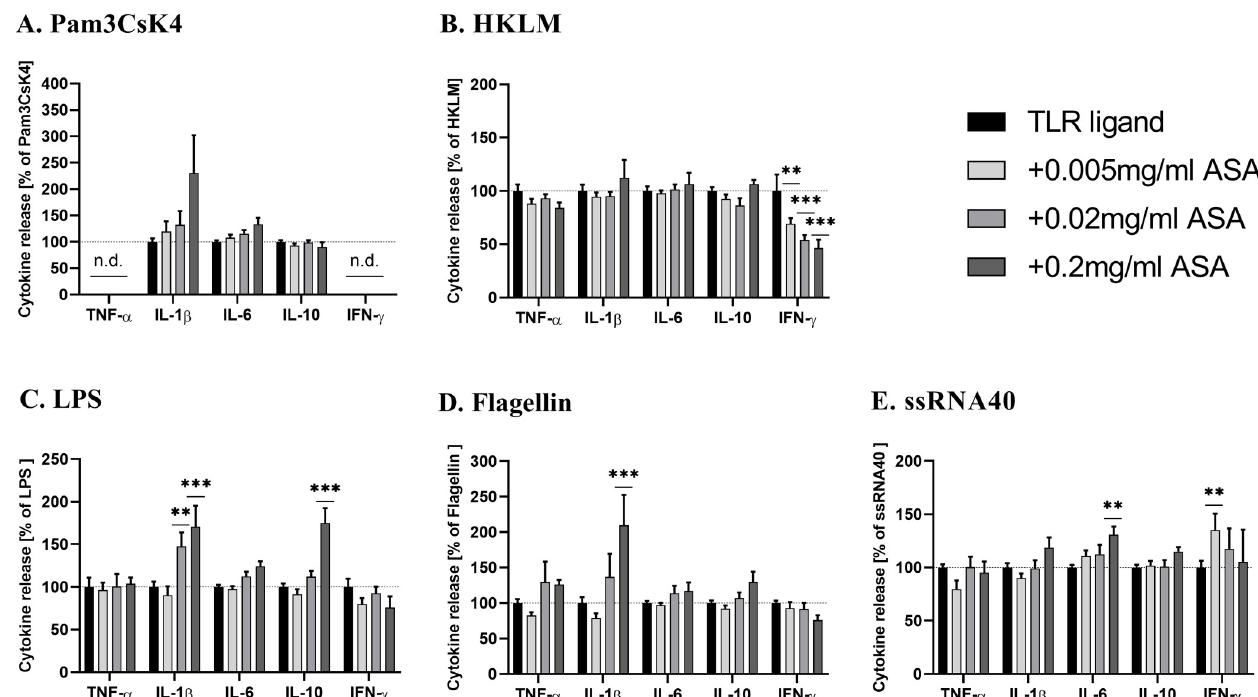
Fig 3. Immunostimulatory effect of different concentrations of acetylsalicylic acid (ASA) on TLR ligand-induced cytokine production in WB. Citrate- anticoagulated blood was incubated with ASA or vehicle for 6h before stimulation with (A) Pam3CsK4 (B) HKLM (C) LPS (D) Flagellin and (E) ssRNA40. The cytokine production by cells stimulated without ASA (vehicle) was set as 100%. Data represent mean ± SD of six experiments performed in triplicate. Differences were significant at p < 0.05 ( � ), p < 0.01 ( �� ) or p < 0.001 ( ��� ) as indicated, compared to WB incubated without ASA. n.d.—not detectable.